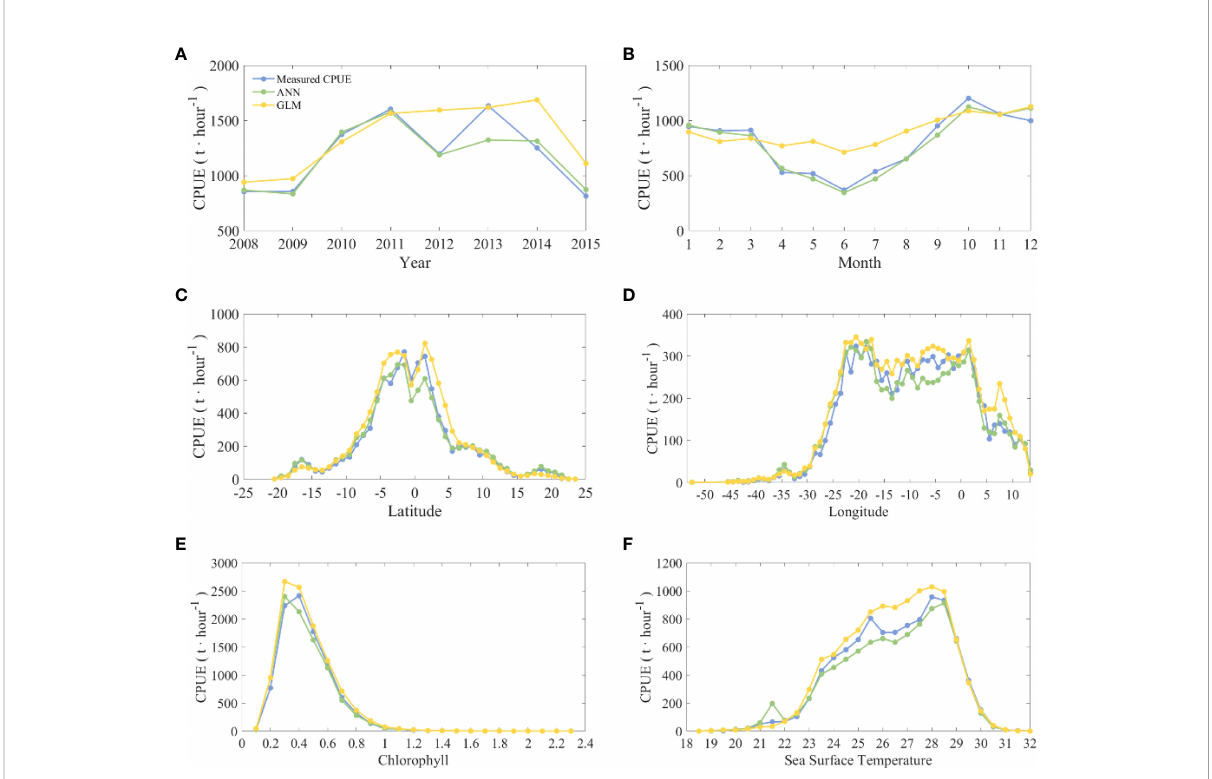
FIGURE 10 Statistical chart of the cumulative amount of CPUE calculated by different models and nominal CPUE according to different explanatory variables. The corresponding explanatory variables in (A – F) are year, month, latitude, longitude, chlorophyll, and sea surface temperature. The blue line is the nominal CPUE, the green line is the CPUE predicted by ANN, and the yellow line is the CPUE predicted by GLM.